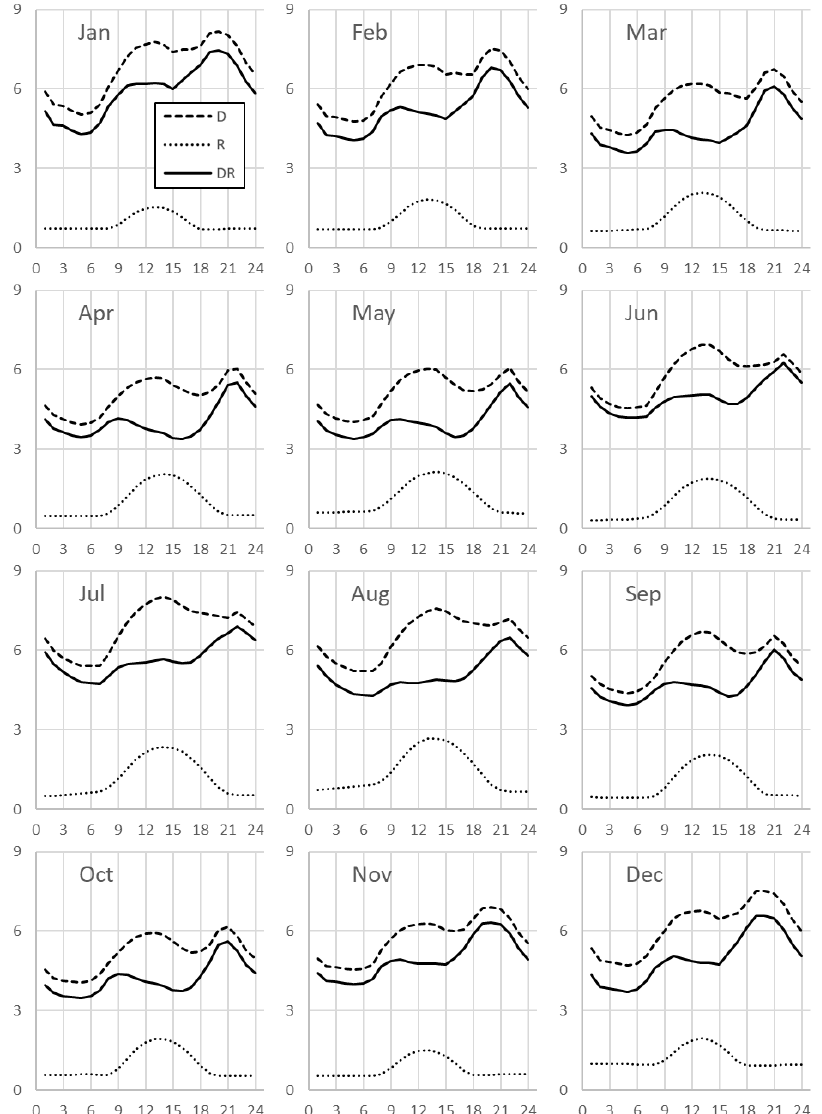
Figure 6. Daily variation using monthly-averaged hourly data: D = demand, DR = demand renewables, R = renewables. Horizontal axis = hour of the day, vertical axis = energy in GWh/h.